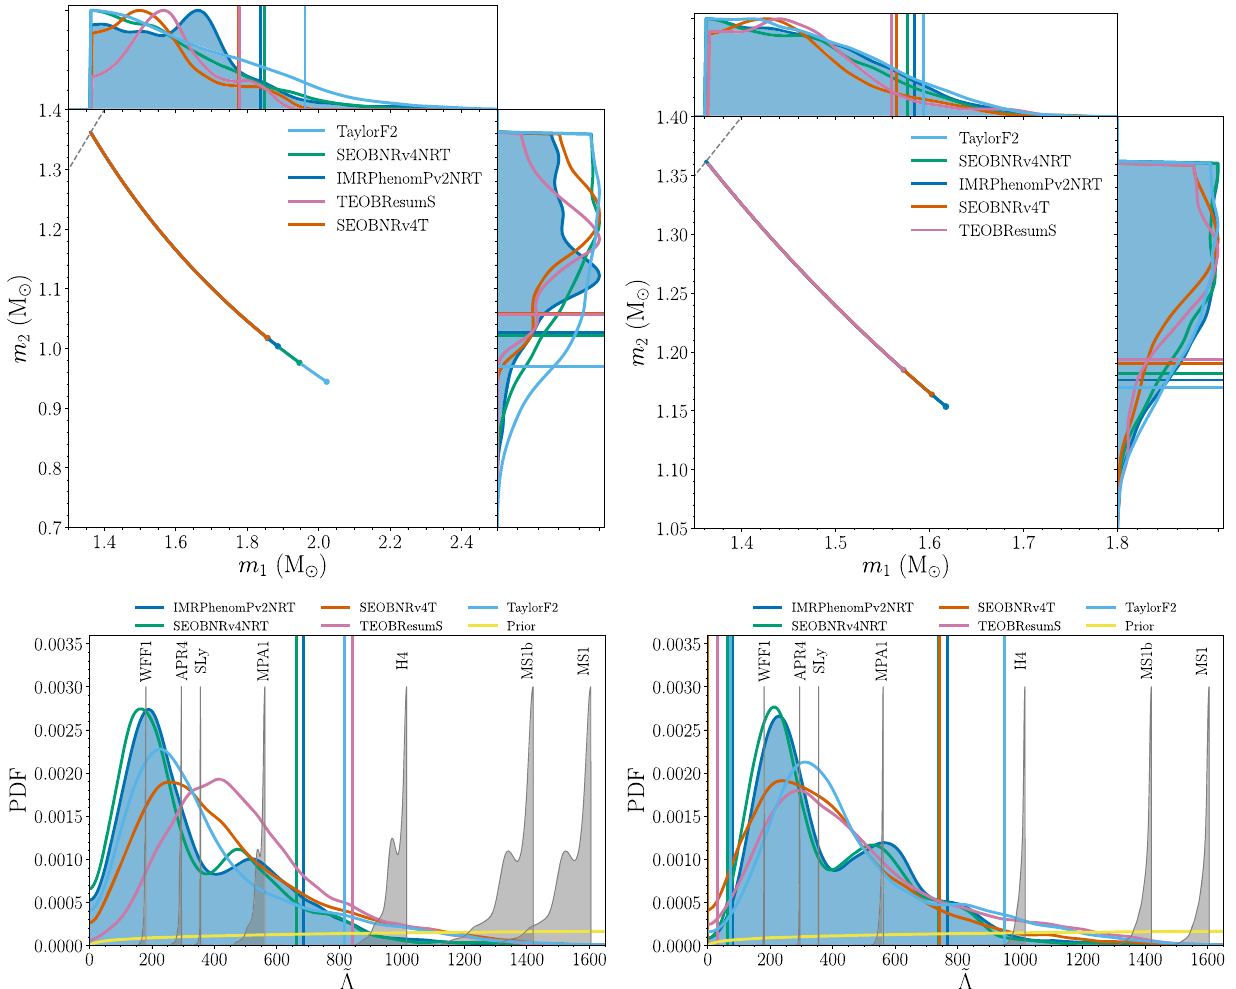
FIG. 9. Posterior distributions for component masses and tidal deformability for GW170817 for the waveform models: IMRPhenomPv2NRT, SEOBNRv4NRT, TaylorF2, SEOBNRv4T, and TEOBResumS. Top: 90% credible regions for the component masses for the high-spin prior a i < 0 . 89 (left) and low-spin prior a i < 0 . 05 (right). The edge of the 90% credible regions is marked by points; the uncertainty in the contour is smaller than the thickness shown because of the precise chirp mass determination. 1D marginal distributions are renormalized to have equal maxima, and the vertical and horizontal lines give the 90% upper and lower limits on m 1 and m 2 , respectively. Bottom: Posterior distributions of the effective tidal deformability parameter (right) priors. These PDFs are reweighted to have a flat prior distribution. The original represented by vertical lines for the high-spin prior (left). For the low-spin prior (right), 90% highest posterior density (HPD) credible intervals are shown instead. Gray PDFs indicate seven representative equations of state (EOSs) using masses estimated with the IMRPhenomPv2NRT